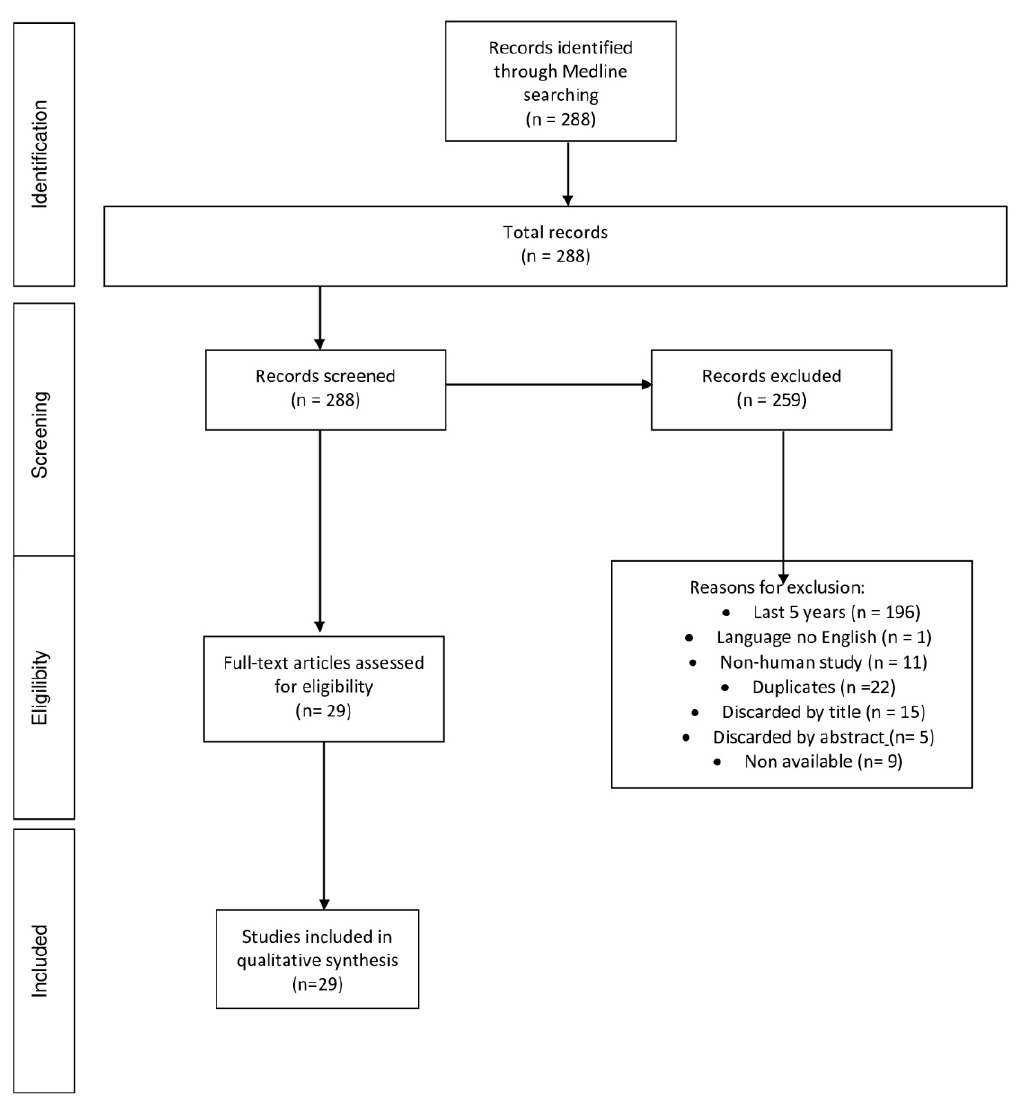
Figure 1. Flowchart representing study